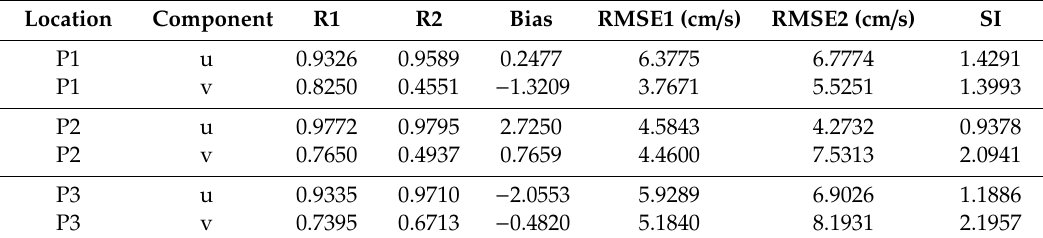
Table 6. Statistics of forecasting dataset (59